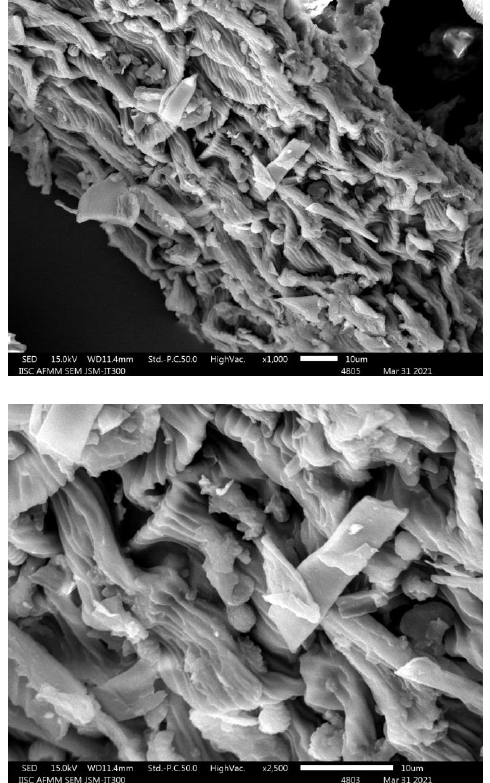
Figure 7. SEM images of TP observed at 1000x (top) and 1200x (bottom) magnification Table 4. Chemical composition of CFS (EDS